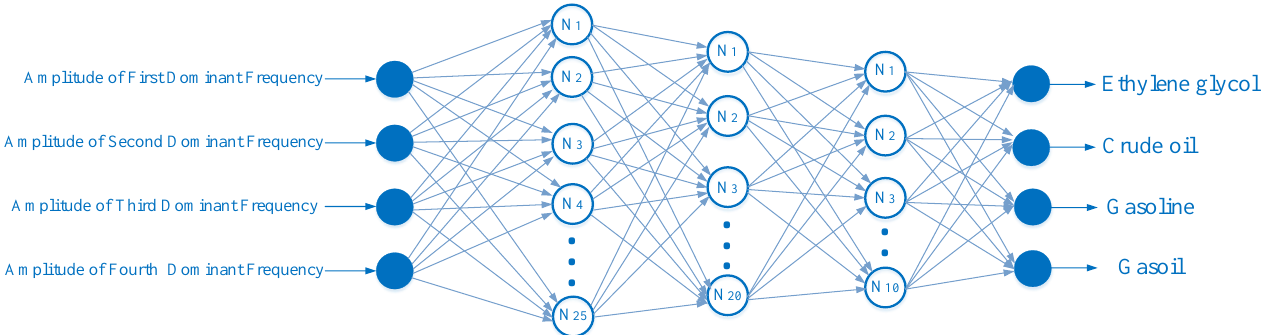
Figure 4. Implemented MLP neural network.